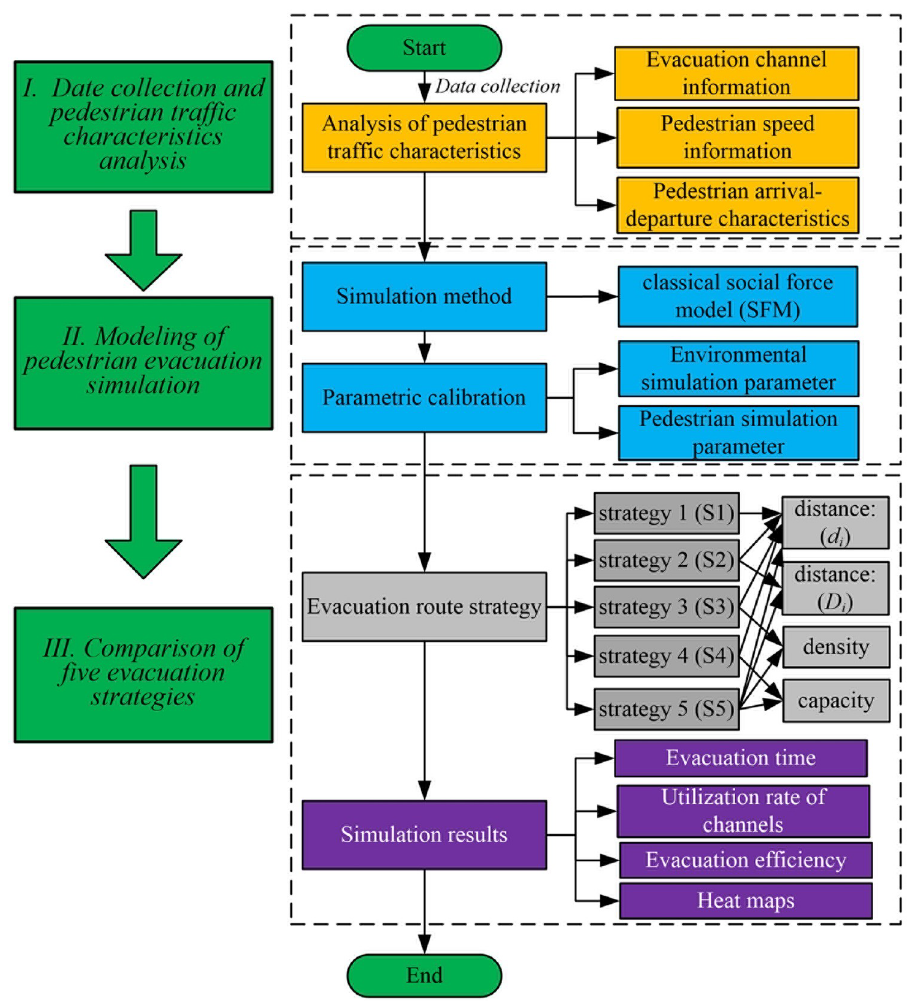
Fig 2. Simulation process of pedestrian evacuation.